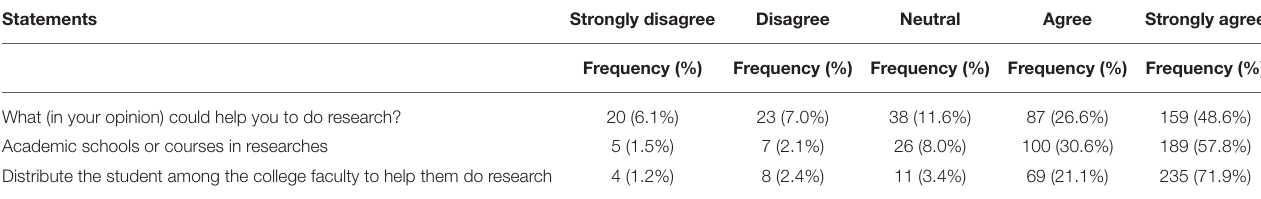
TABLE 5 | Attitudes of the students toward research.